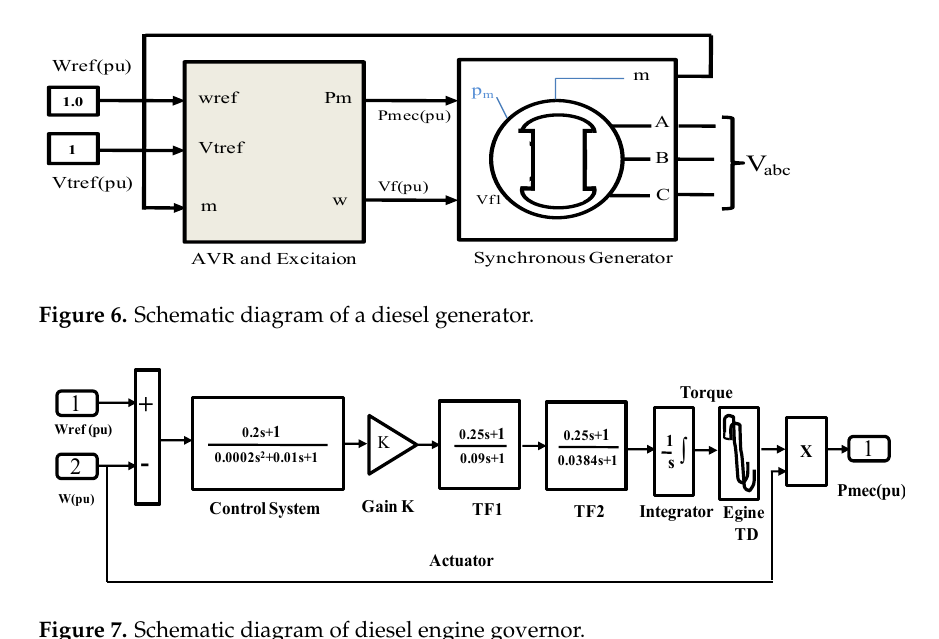
Figure 7. Schematic diagram of diesel engine